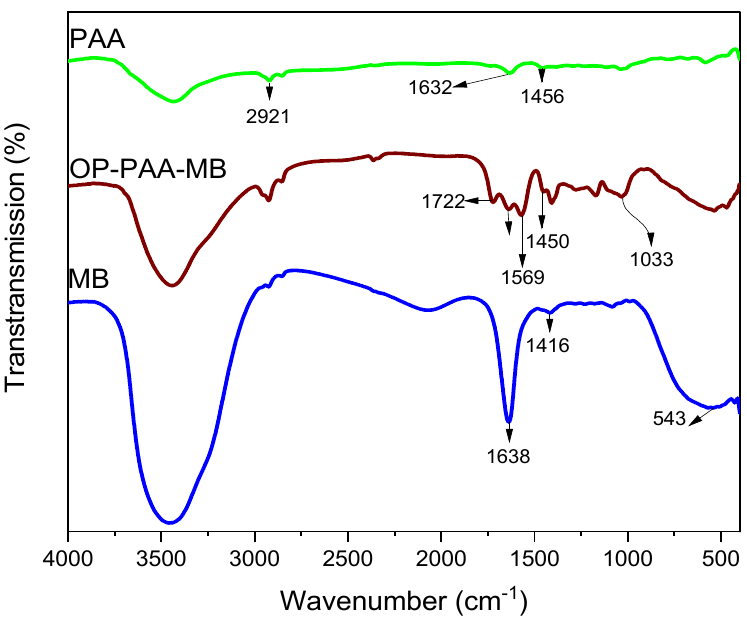
Figure 3. FT-IR spectra of PAA, MB, and MB adsorbed on polymer E hydrogel.